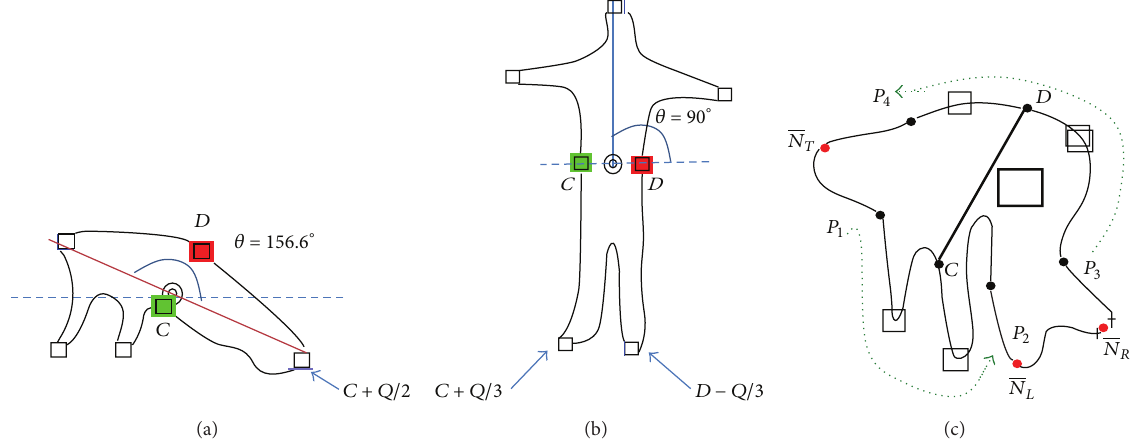
Figure 5: Convex points in different postures: (a) lying, (b) standing, and (c)